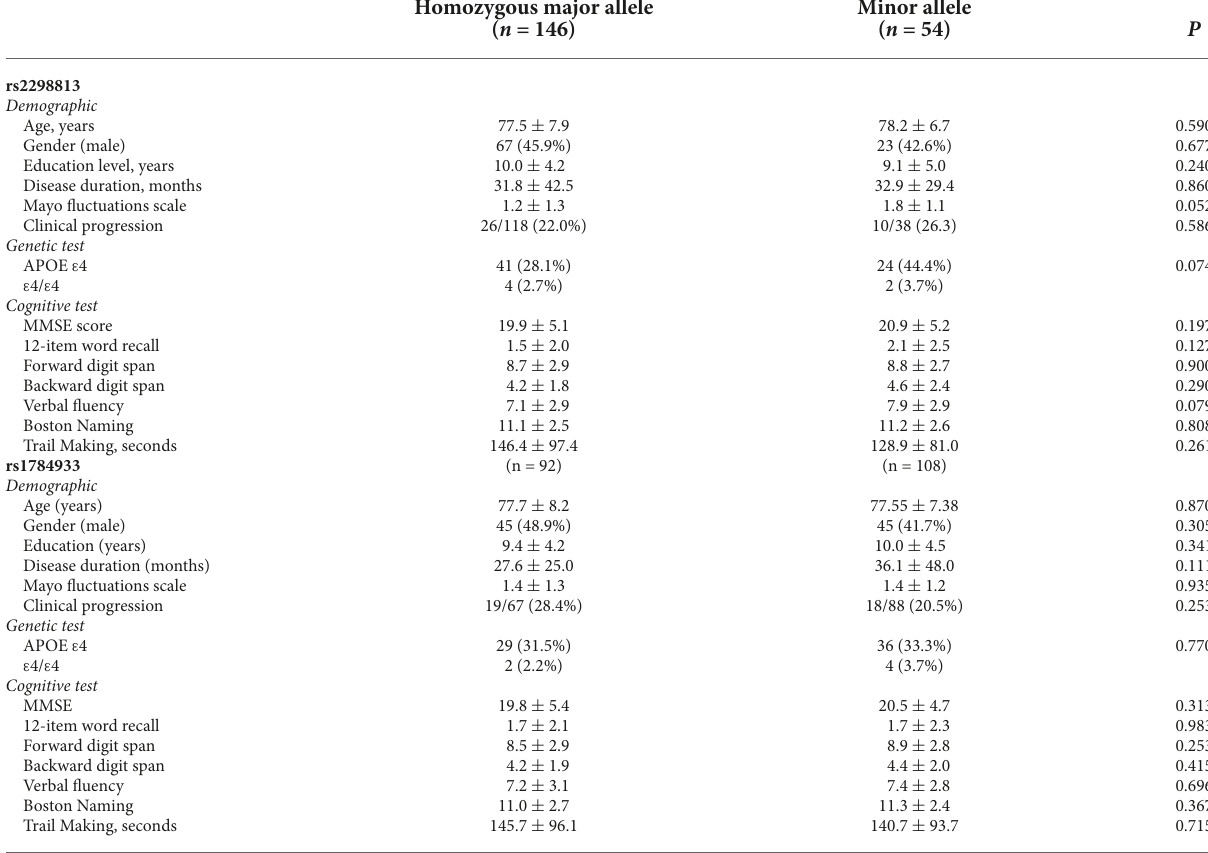
TABLE 1 The demographic data and cognitive test performance of the homozygous major allele carriers and minor allele